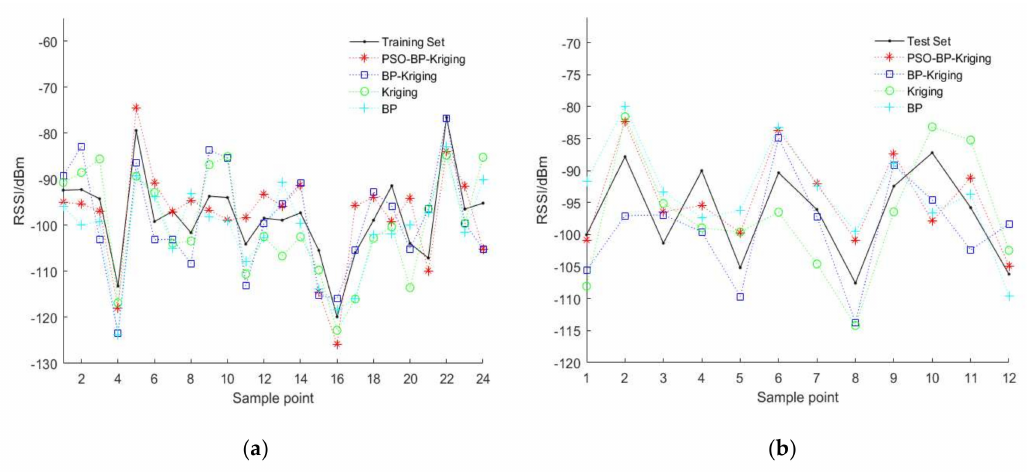
Figure 4. Prediction results. ( a ) Training set prediction results; ( b ) Test set prediction